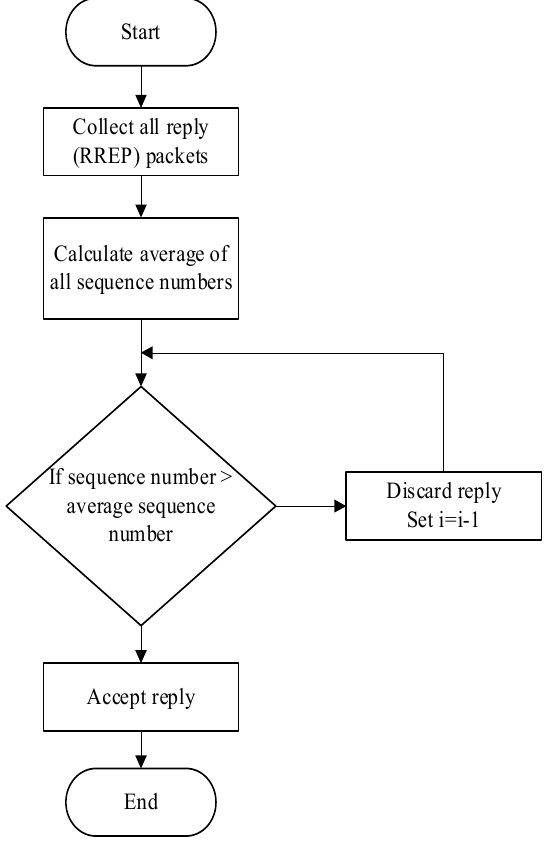
Figure 2. Proposed technique flowchart